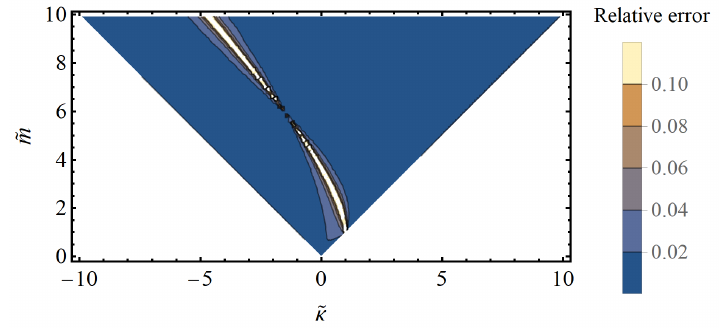
Figure 15 . The relative error of the empirical formula (4.56) as compared to the numeric result. The bright band cutting across the plot is where the z (1 , 1) ∗ crosses zero, hence the large relative